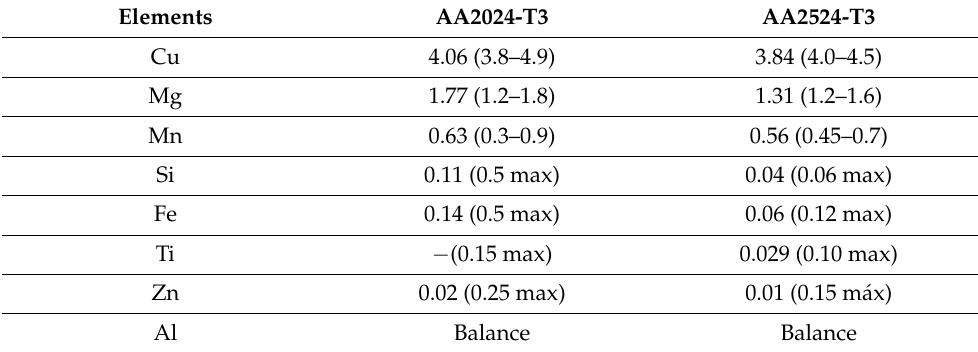
Table 1. Analyzed and nominal chemical composition (wt %) of the AA2024-T3 and AA2524-T3 alloys [39].